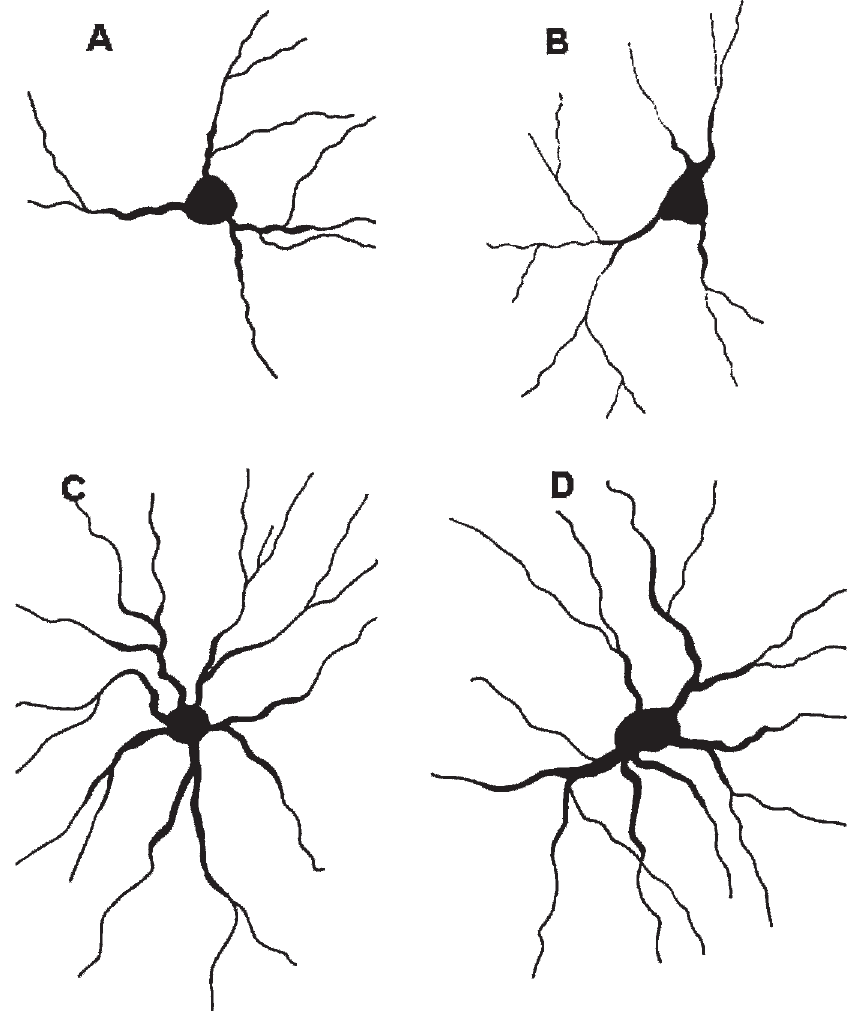
Figure 3 - Camera lucida tracings of basolateral amygdaloid neurons from control rats A) and rats treated with Bacopa monniera for 4 weeks at doses of 20 mg/kg B), 40 mg/kg C) and 80 mg/kg D).